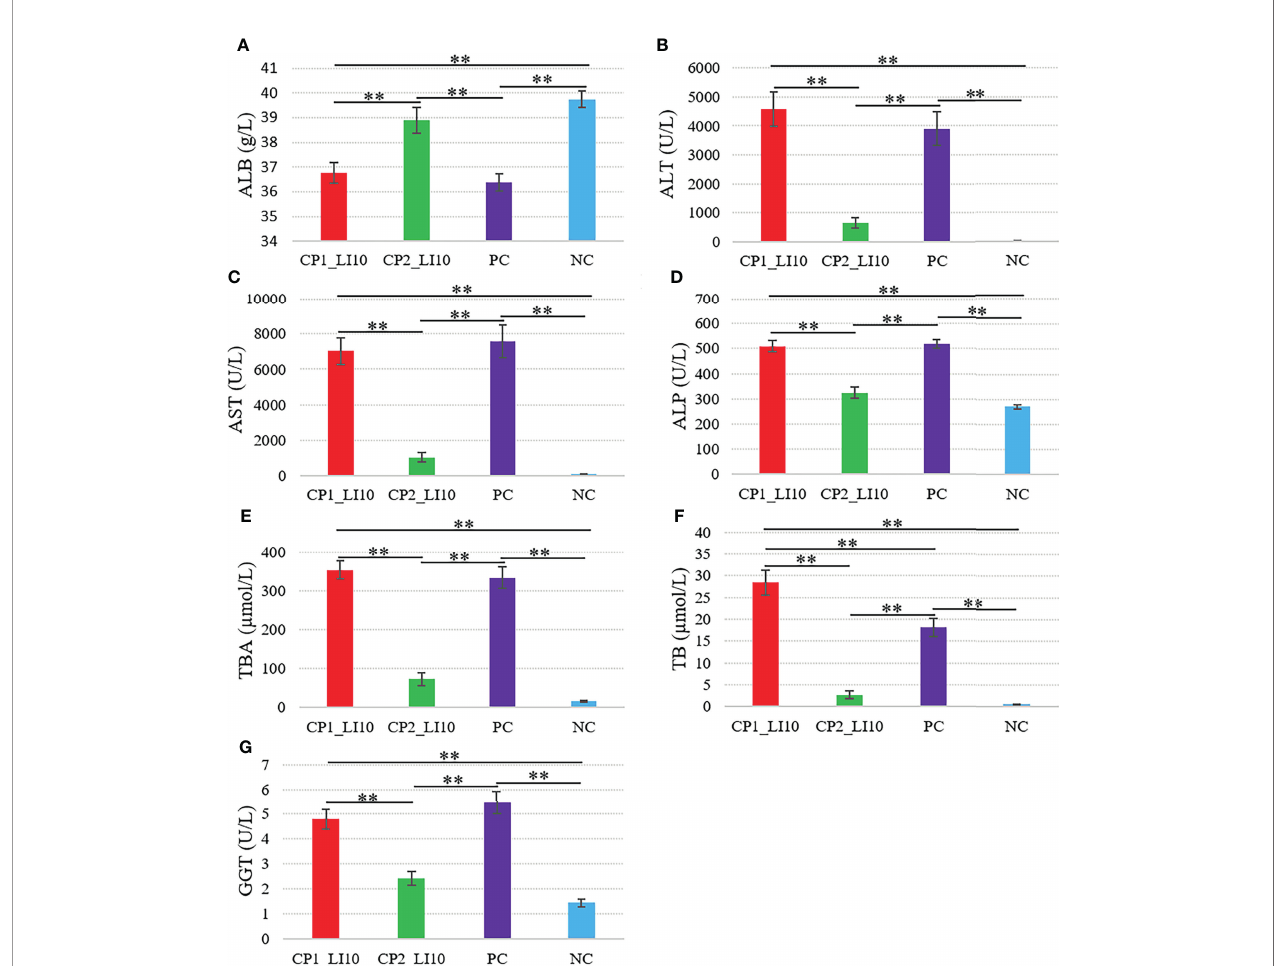
FIGURE 3 | Comparisons of liver function variables in the LI10 cohorts with different cytokine pro fi les (i.e., CP1_LI10 and CP2_LI10 cohorts) and control cohorts. PC represents positive control; NC represents negative control. (A) ALB; (B) ALT; (C) AST; (D) ALP; (E) TBA; (F) TB; (G) GGT. ** represented P <